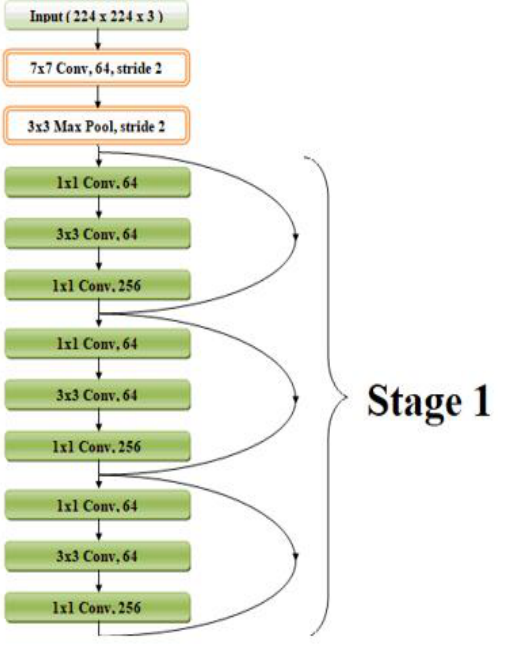
Figure 6. Stage 1 Architecture of ResNet50